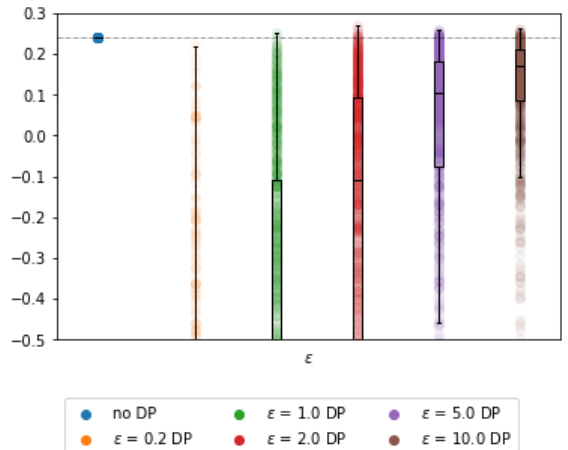
Figure 8. R 2 over ε for the Garment employee productivity data set (5 iterations, 1000 repetitions, and γ =